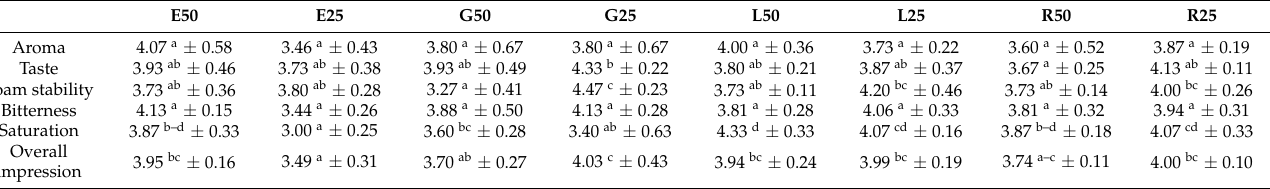
Table 4. Sensory analysis of Witbier-style beers.